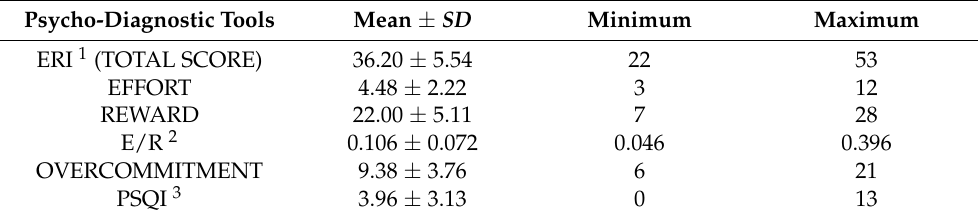
Table 2. Results of the Effort/Reward Imbalance Test and Pittsburgh Sleep Quality Index. Psycho-Diagnostic Tools Mean ± SD Minimum Maximum ERI 1 (TOTAL SCORE) 36.20 ± 5.54 EFFORT REWARD 22.00 ± 5.11 OVERCOMMITMENT